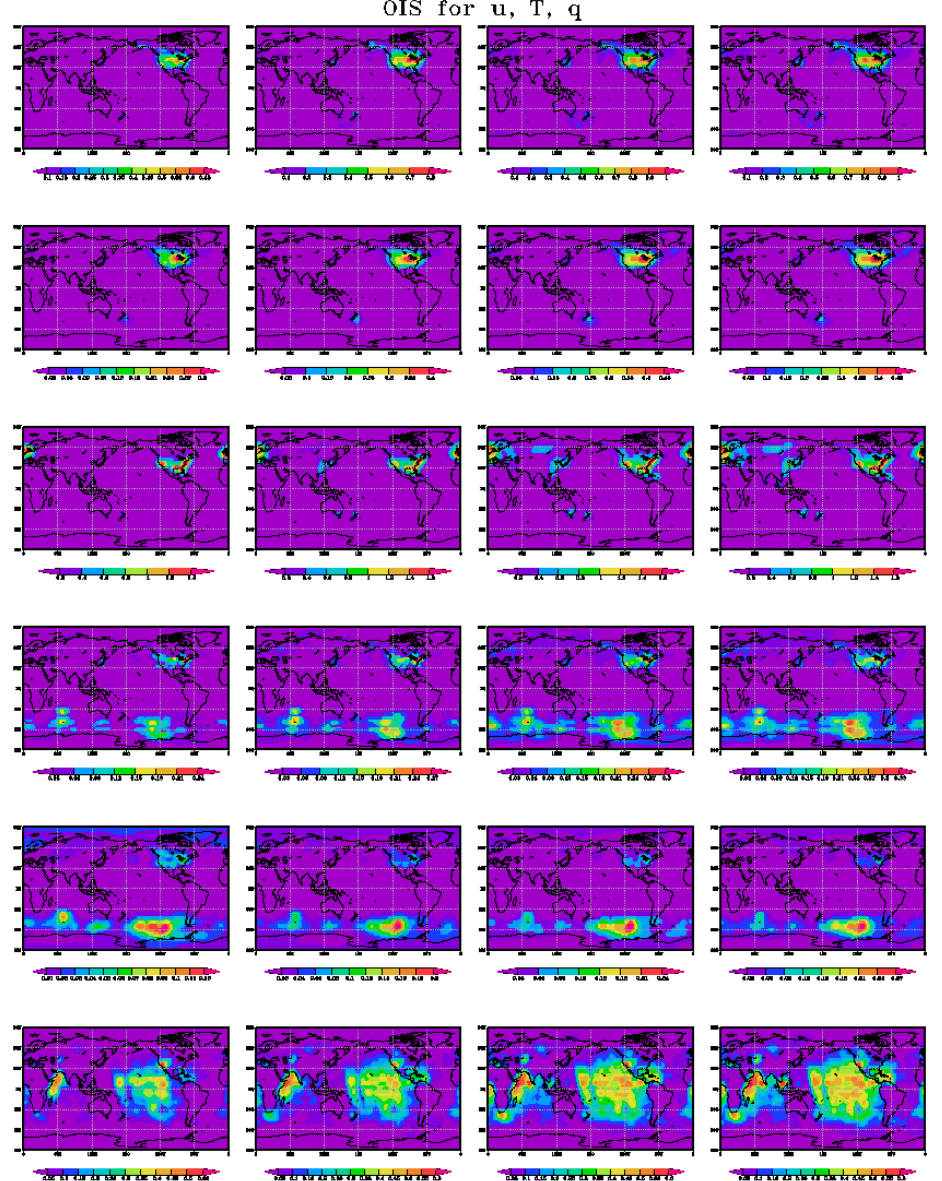
Fig. 5. Observation impact signal (OIS) for u 500 ,t 500 , and q 1000 . From the left to the right on each row, K = 30 , 60 , 100 , and 116. Rows 1 to 3 for u 500 ,t 500 , and q 1000 with ndat = 6, and rows 4 to 6 for ndat =